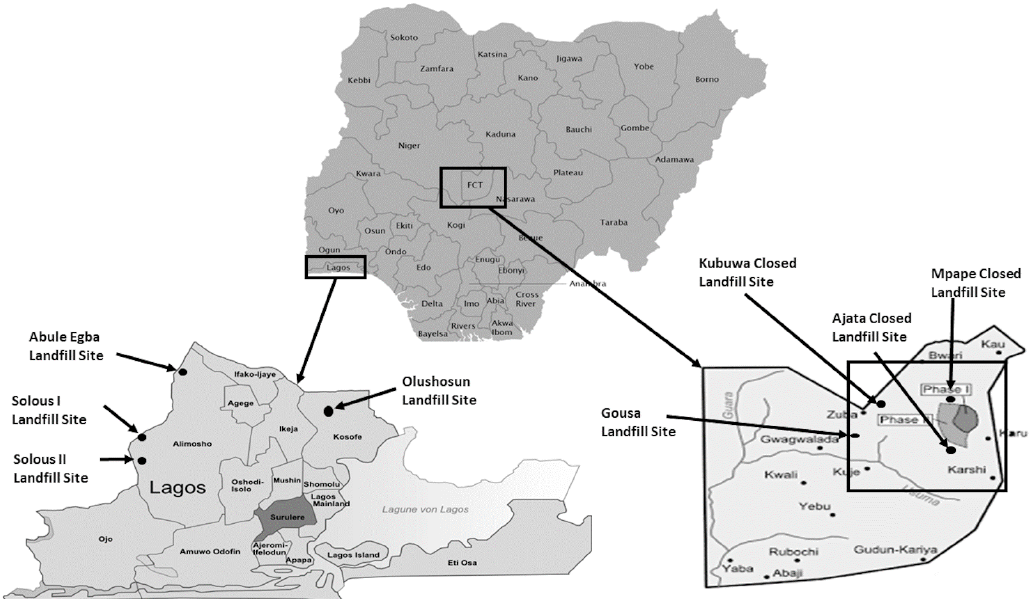
Figure 1. Map of the Lagos and Abuja metropolitan areas indicating their major landfill sites